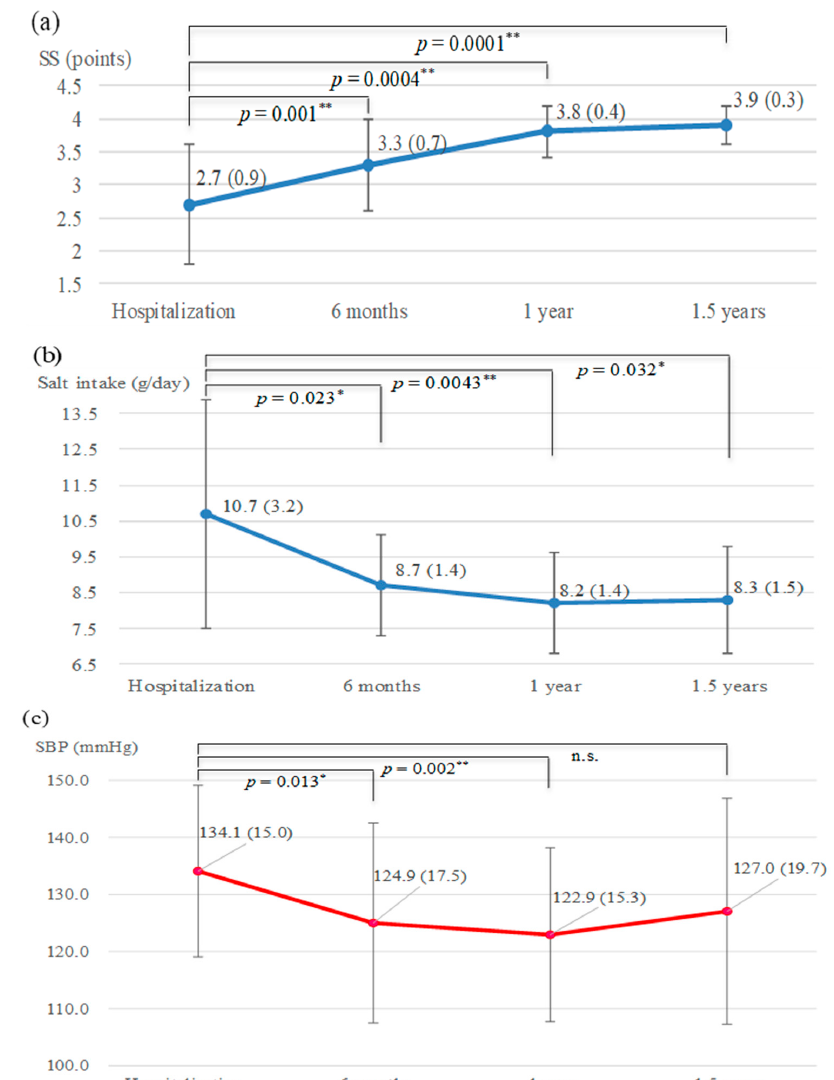
Figure 2. Change in SS regarding dietary intake, salt intake, and BP. Mean (SD). * p < 0.05, ** p < 0.01, n = 15. Abbreviations: SS, stage scores; SBP, systolic blood pressure; n.s., not significant. ( a ) A significant increase in SS was found 1.5 years after leaving compared with that at hospitalization ( p < 0.01). ( b ) ESI decreased in 1.5 years after leaving compared with that at hospitalization ( p < 0.05). ( c ) SBPs significantly decreased at 6 months and 1 year compared with hospitalization ( p < 0.05), however an upward trend in 1.5 years from 1 year after leaving.